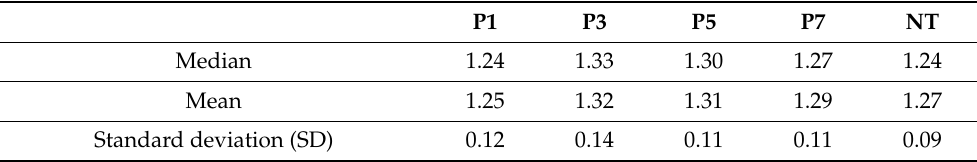
Table 1. Median, mean and standard deviation (SD) of DNA index (DI) obtained by static cytometry of 3T3 cells’ nucleus when treated with cold atmospheric plasma for 1 (P1), 3 (P3), 5 (P5), and 7 (P7) minutes. NT = non-treated